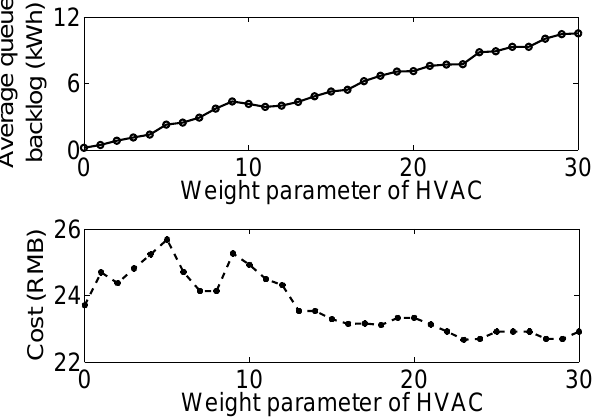
Figure 11. Average delay queue backlog of HVAC and the electricity bills of controllable load.